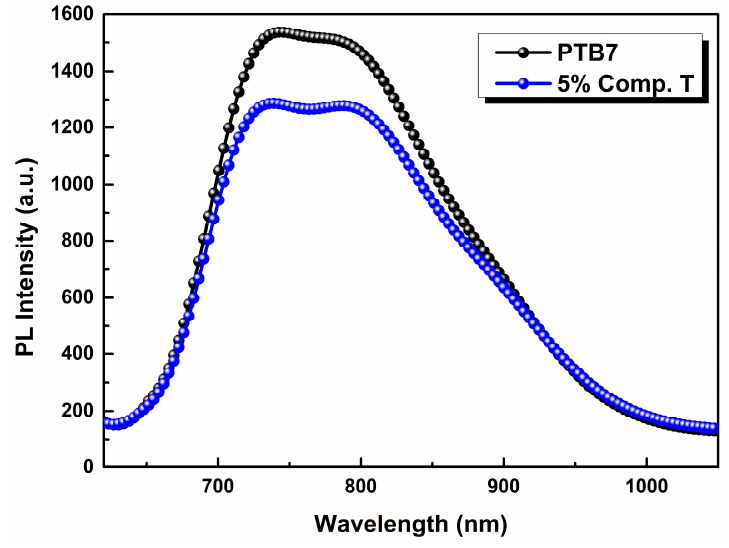
Figure 4. Photoluminescence (PL) spectra of PTB7 (black) and PTB7:compound T (5%; blue) thin film on a Si substrate.